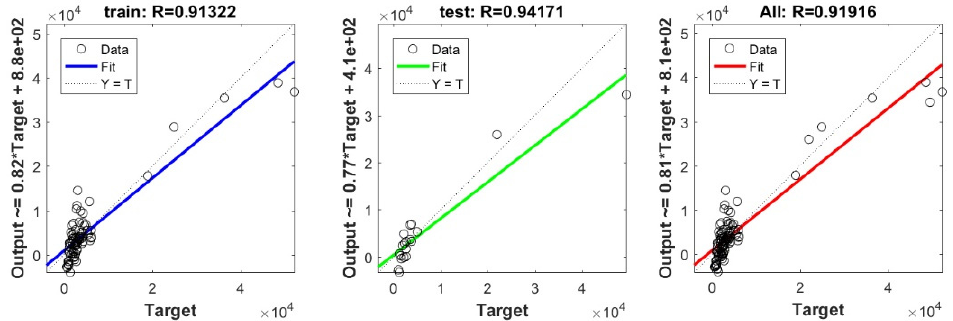
Figure A9. Scatter plots between target and output values by the Ridge model.